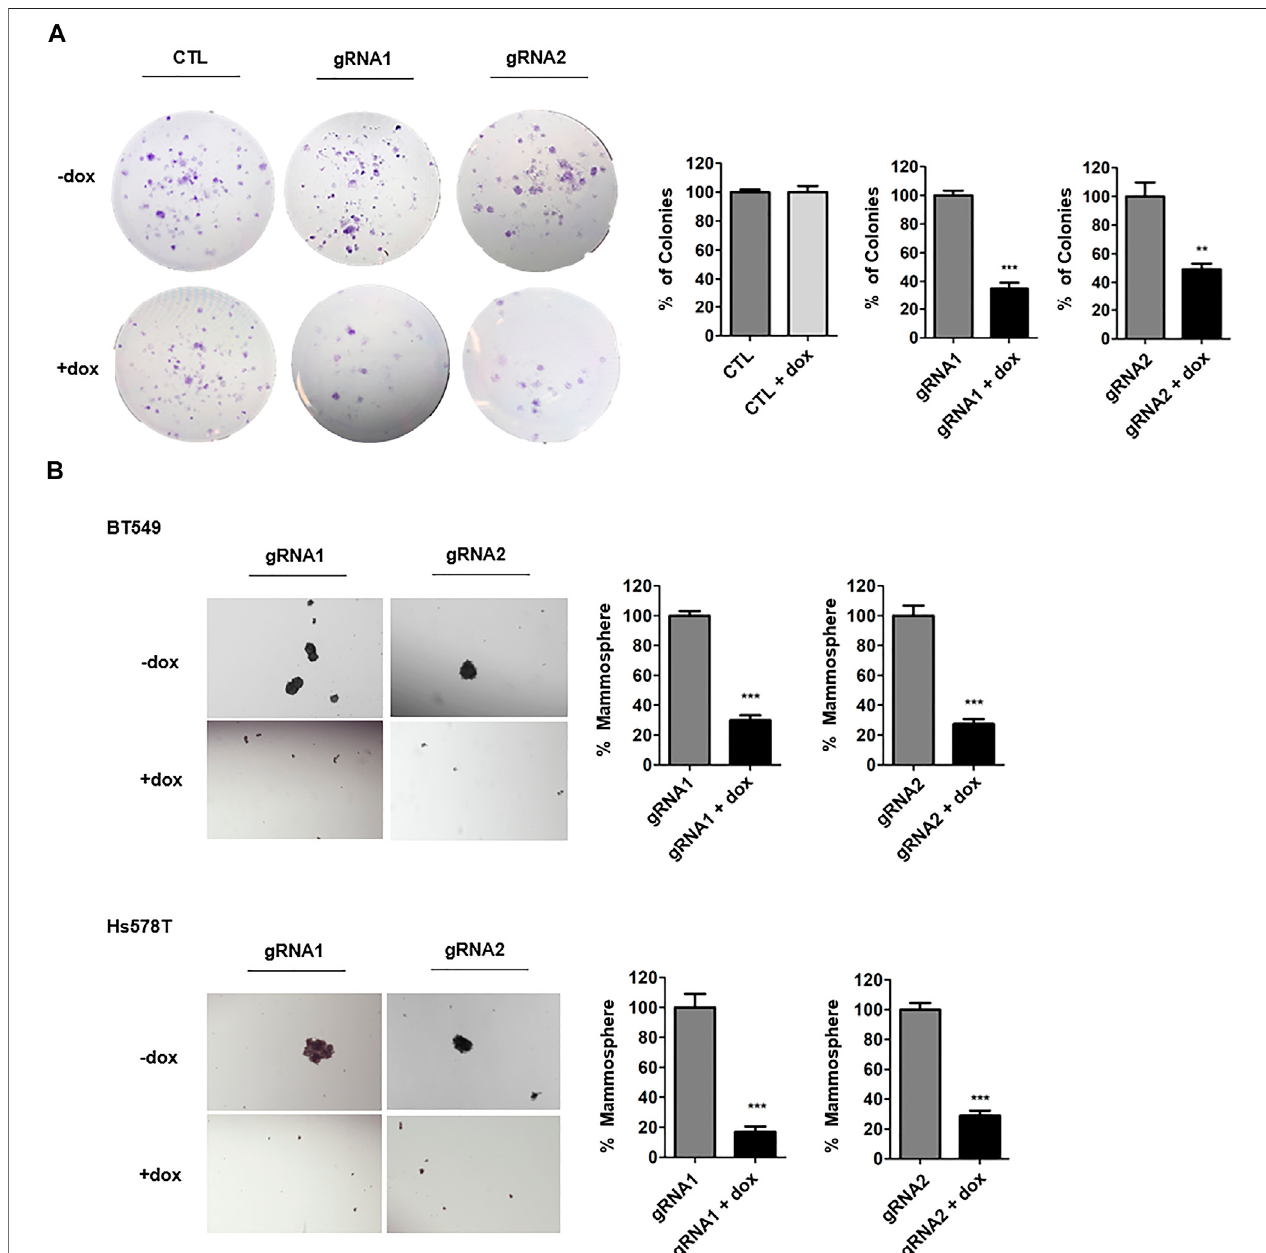
FIGURE2| ANLNpromotesstemcellpropertyofTNBC. (A) BT549cellsexpressingtet-onANLNorCTLgRNAweretreatedwithdox(100 ng/ml)for7 days.Cells were then cultured for colony formation assay for 10 days. Representative images are shown. Colony number was counted and depicted in bar graphs. Error bars, mean ± SEM of 3 independent experiments. ***, p < 0.001. (B) BT549 and Hs578T cells expressing tet-on ANLN or CTL gRNA were treated with dox (100 ng/ml) for 7 days. Cells were then seeded for mammosphere formation assay. Representative images are shown. Bar graphs depict the mammosphere number. Error bars, mean ± SEM of 3 independent experiments. ***, p <